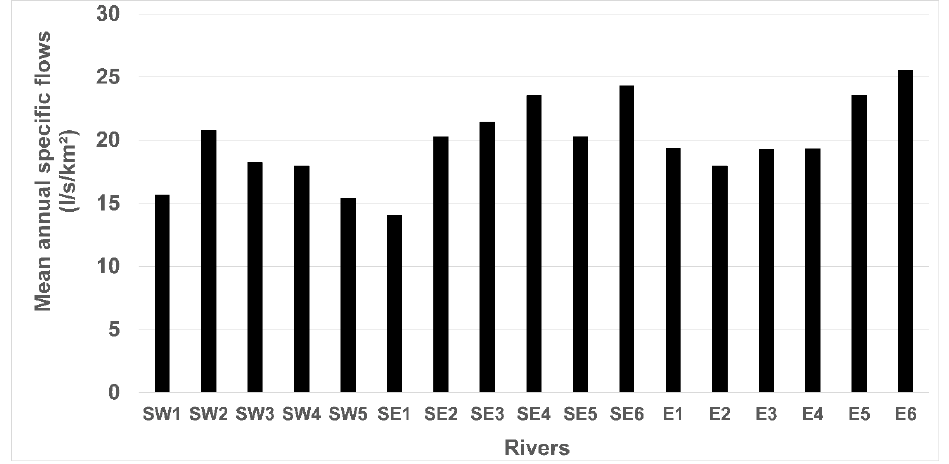
Figure 2. Comparison of mean annual flows in the three hydroclimatic regions from 1930 to 2019. The correlation analysis between mean annual flow values and physiographic varia-